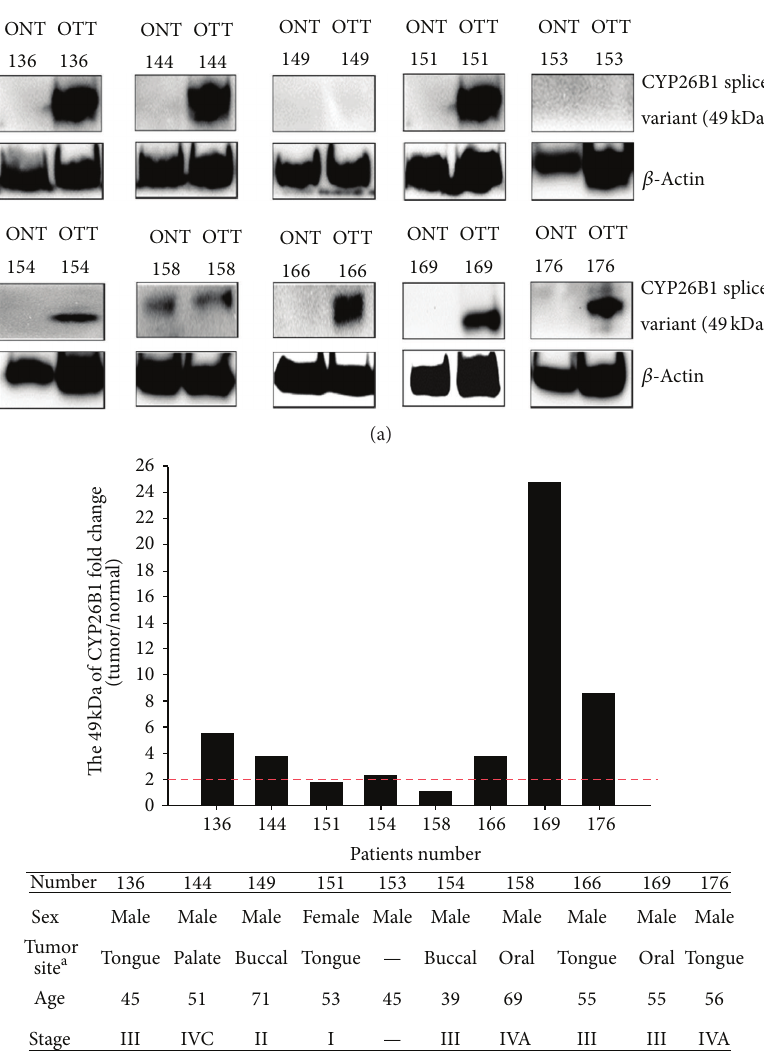
Figure 4: Protein level of the CYP26B1 splice variant (49kDa) in human OSCC tissue (T) and adjacent normal tissue (N). (a) Level of CYP26B1 splice variant protein expression in 10 pairs of oral tumor tissue and adjacent tissue; 𝛽 -actin was used as a control for protein loading and detection. (b) Expression protein fold change level of CYP26B1 in 10 pairs of oral tumor tissue compared with the adjacent normal